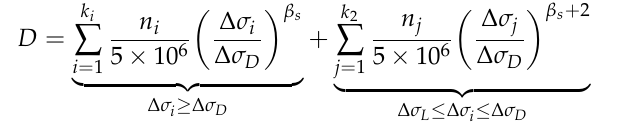
Table 1. Fatigue damage caused by a single pass by fatigue-load calculation model II. Fatigue Detail Location of Stress Concentration at the Bearing Structure of Cable 1